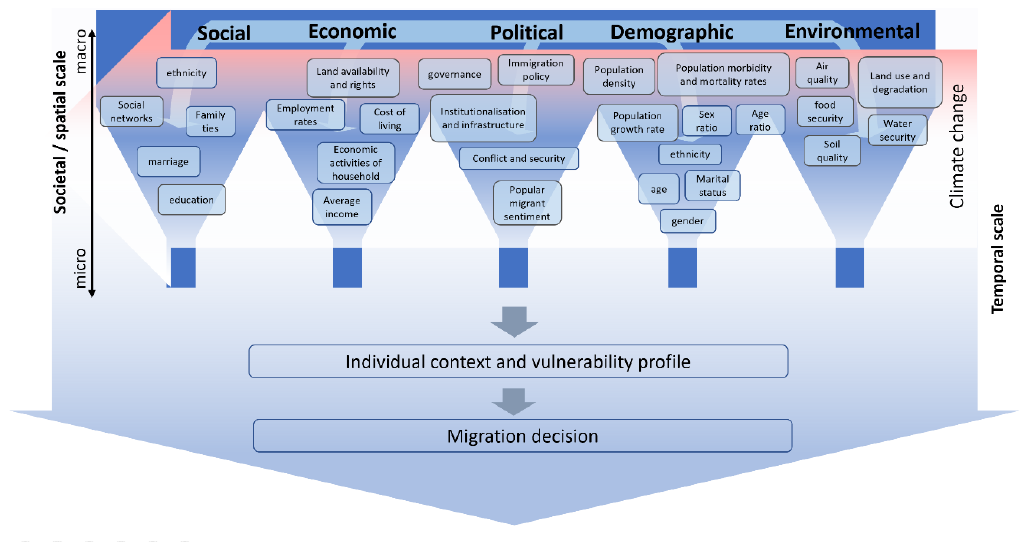
Figure 3. A simple representation of interactions between drivers and classes of drivers and the role of climate change as a source of external pressure on all drivers simultaneously.